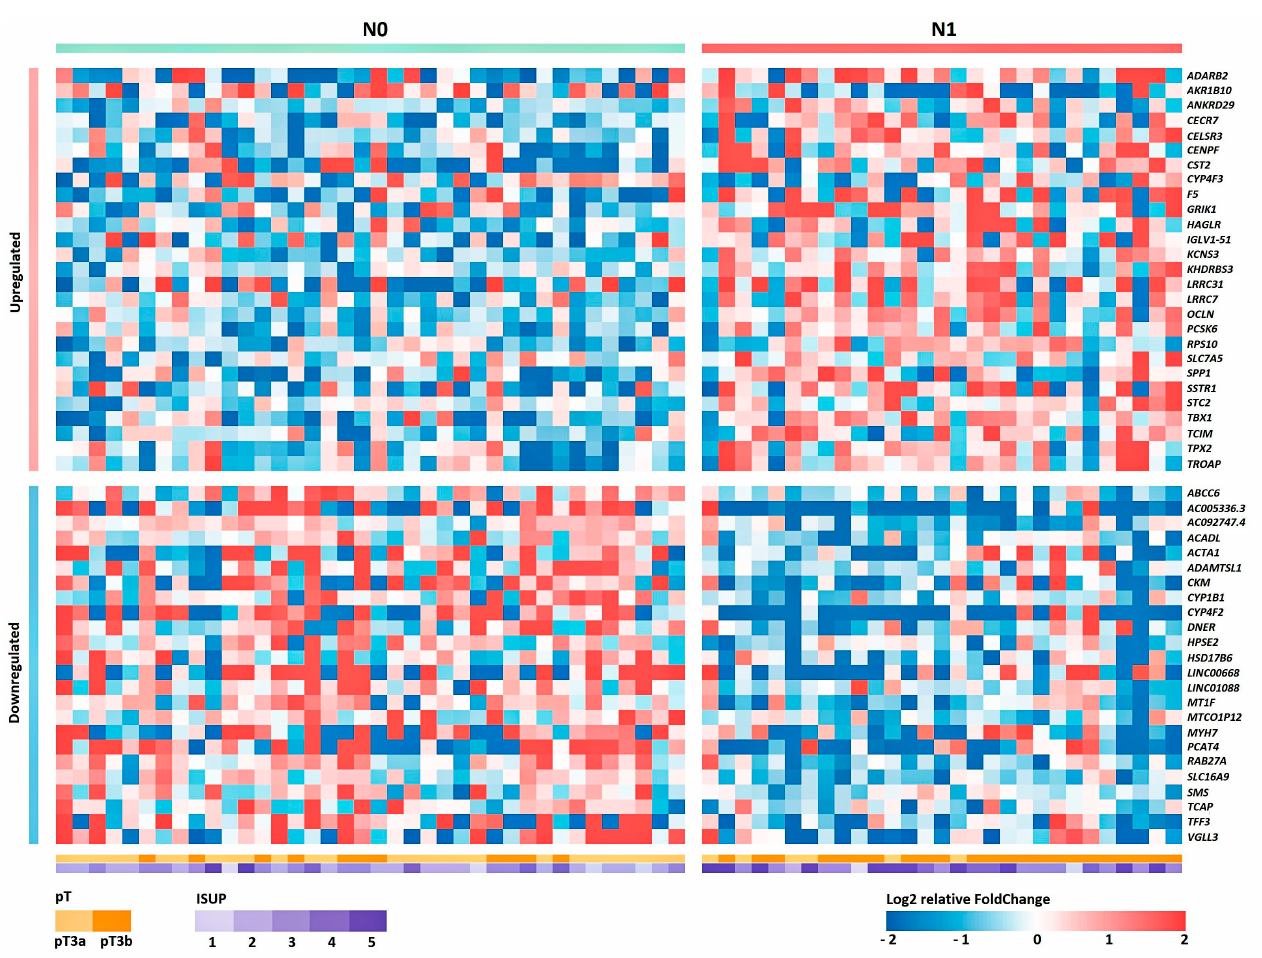
Figure 1. Heat map of the relative level of expression of 50 DEGs between groups N0 and N1 for Russian patients with LAPC. Cell colors correspond to the binary logarithm of the ratio of the expression level in the current sample to the average level for all samples (for each gene).